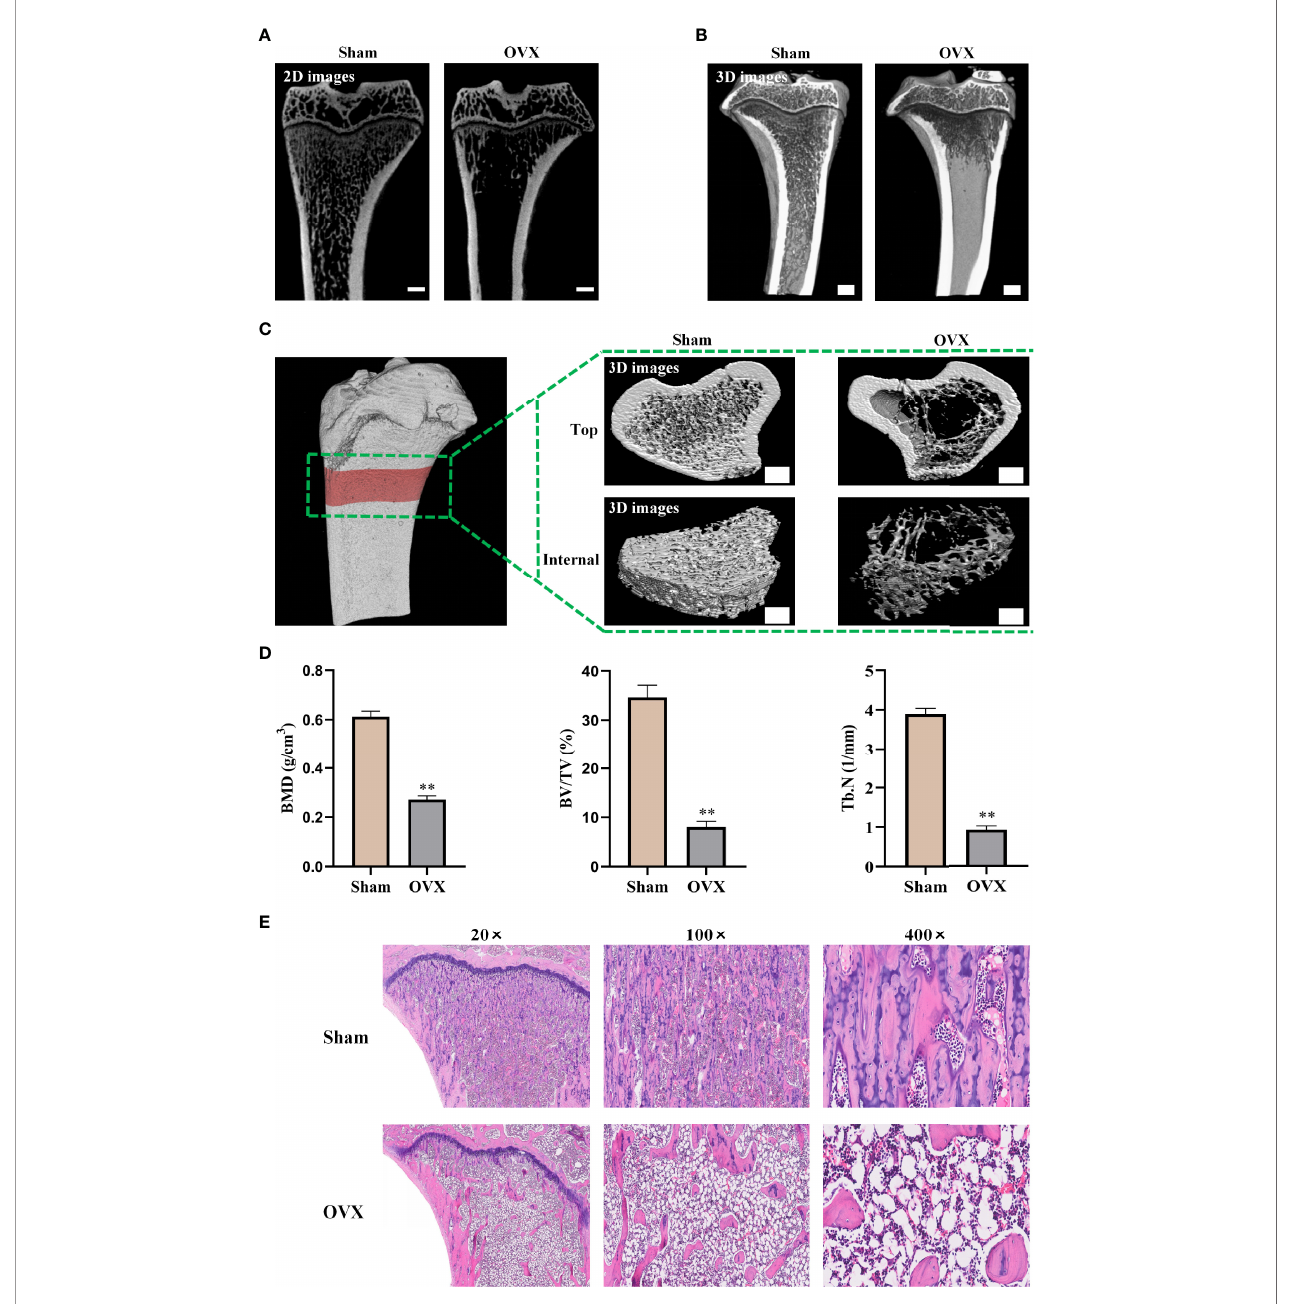
FIGURE 4 | Con fi rmation of osteoporosis model in ovariectomized rats. (A) 2D images of the tibia bone in two groups (scale bars, 1 mm). (B) Tibia bone visualized and vertical-sectioned images (scale bars, 1 mm). (C) 3D constructed images of the tibia proximal metaphysis (top, trabecular bone with cortical bone; internal, trabecular portion) (scale bars, 1 mm). (D) Quantitative presentation of microarchitectural parameters including BMD, BV/TV, and Tb.N. (E) H&E staining images of tibia bone. BMD, bone mineral density; BV/TV, trabecular bone volume; Tb.N, trabecular number. The data are presented as means ± SEM. ** p < 0.01 vs . Sham